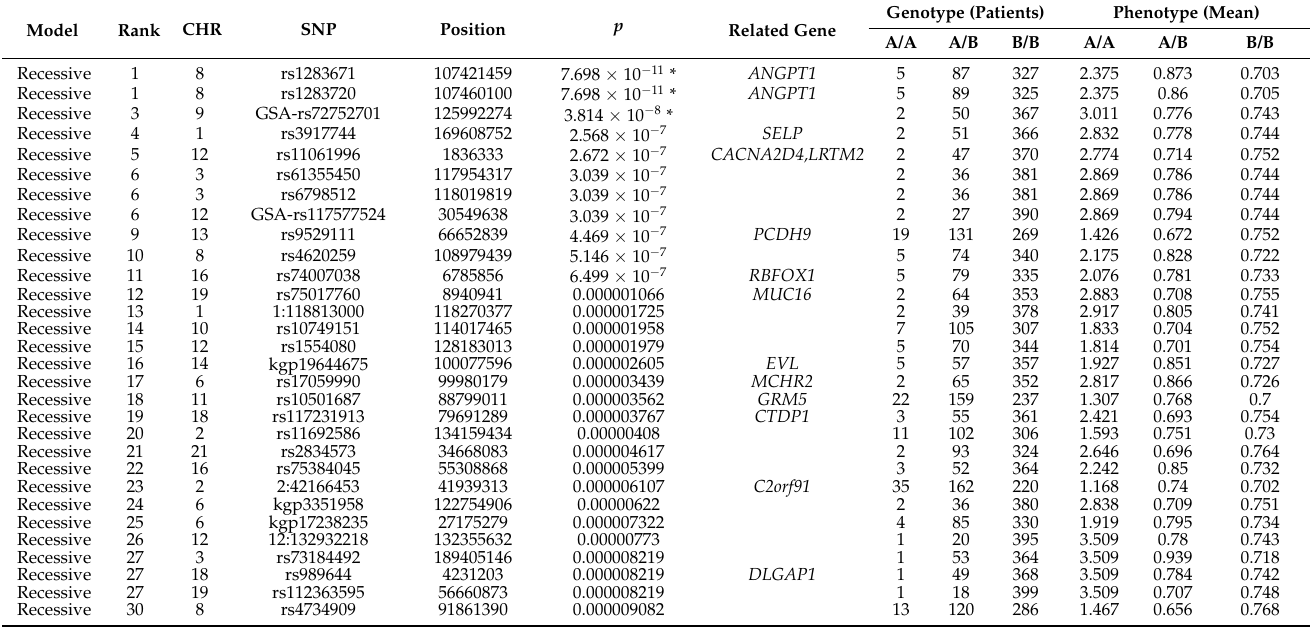
Table 4. Top 30 candidate SNPs selected from the GWAS (recessive